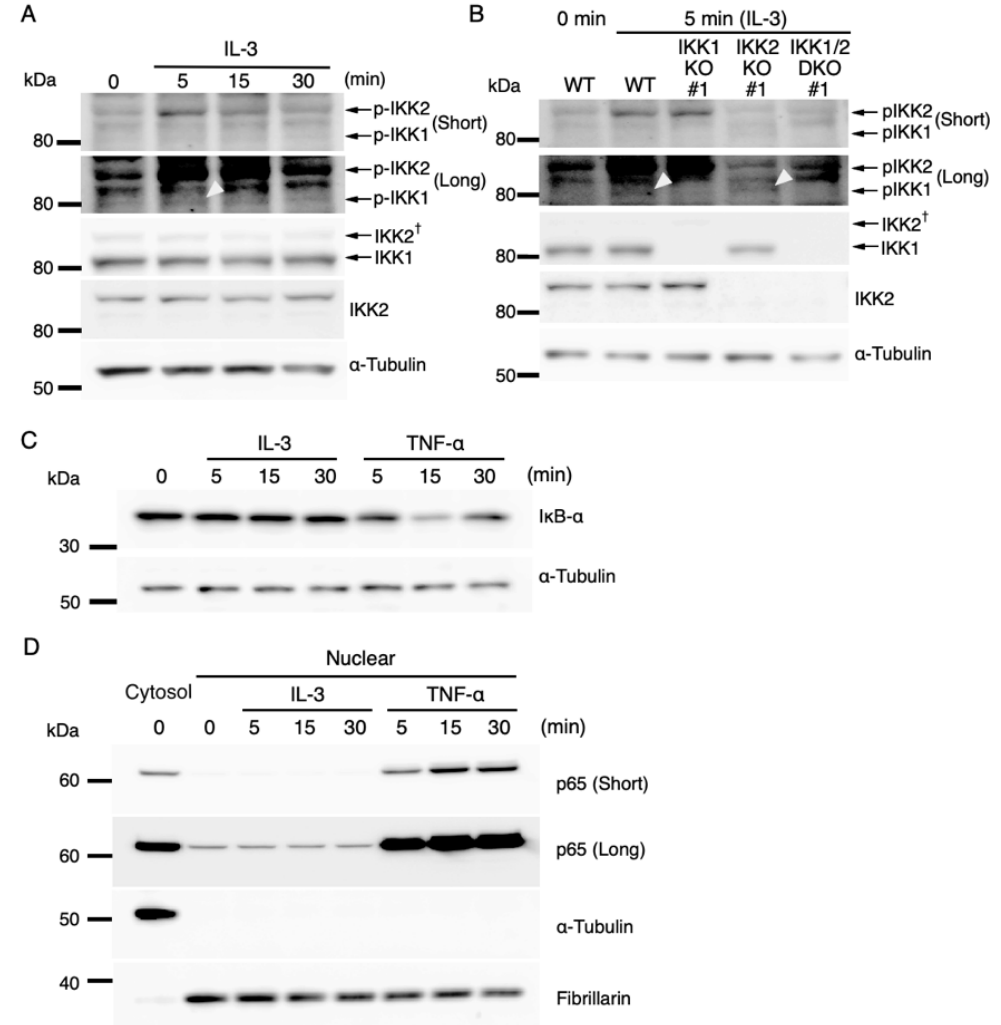
Figure 3. IL-3-induced IKK activation was not associated with the degradation of I κ B- α followed by nuclear translocation of p65. ( A ) Phosphorylation of IKKs after IL-3 stimulation. Following IL-3 deprivation for 6 h, Ba/F3 cells were stimulated with IL-3 for the indicated times, and whole-cell lysates were immunoblotted using the indicated Abs. Long and short exposures to detect phosphorylated IKK1 and IKK2 are shown. An arrowhead indicates the band corresponding to phosphorylated IKK1 at 5 min after IL-3 stimulation. A dagger denotes the detection of IKK2 by potential cross-reactivity of the anti-IKK1 Ab. ( B ) Phosphorylation of IKKs in IKK KO cells after IL-3 stimulation. Following IL-3 deprivation for 6 h, Ba/F3 parental (WT), IKK1 KO, IKK2 KO, and IKK1/2 DKO cells were stimulated with IL-3 for 5 min. Immunoblot analysis was performed with whole-cell lysates using the indicated Abs. Arrowheads indicate the bands corresponding to phosphorylated IKK1. ( C ) Degradation of I κ B- α by TNF- α but not by IL-3 stimulation. Following IL-3 deprivation, Ba/F3 cells were stimulated with IL-3 or TNF- α for the indicated durations, and whole-cell lysates were immunoblotted using the indicated Abs. ( D ) Induction of nuclear translocation of p65 by TNF- α but not by IL-3 stimulation. Following IL-3 deprivation for 6 h, Ba/F3 cells were stimulated with IL-3 or TNF- α for the indicated times and immunoblotted with Abs to the cytosol marker α -tubulin and the nuclear marker fibrillarin. Long and short exposures to detect p65 are shown.